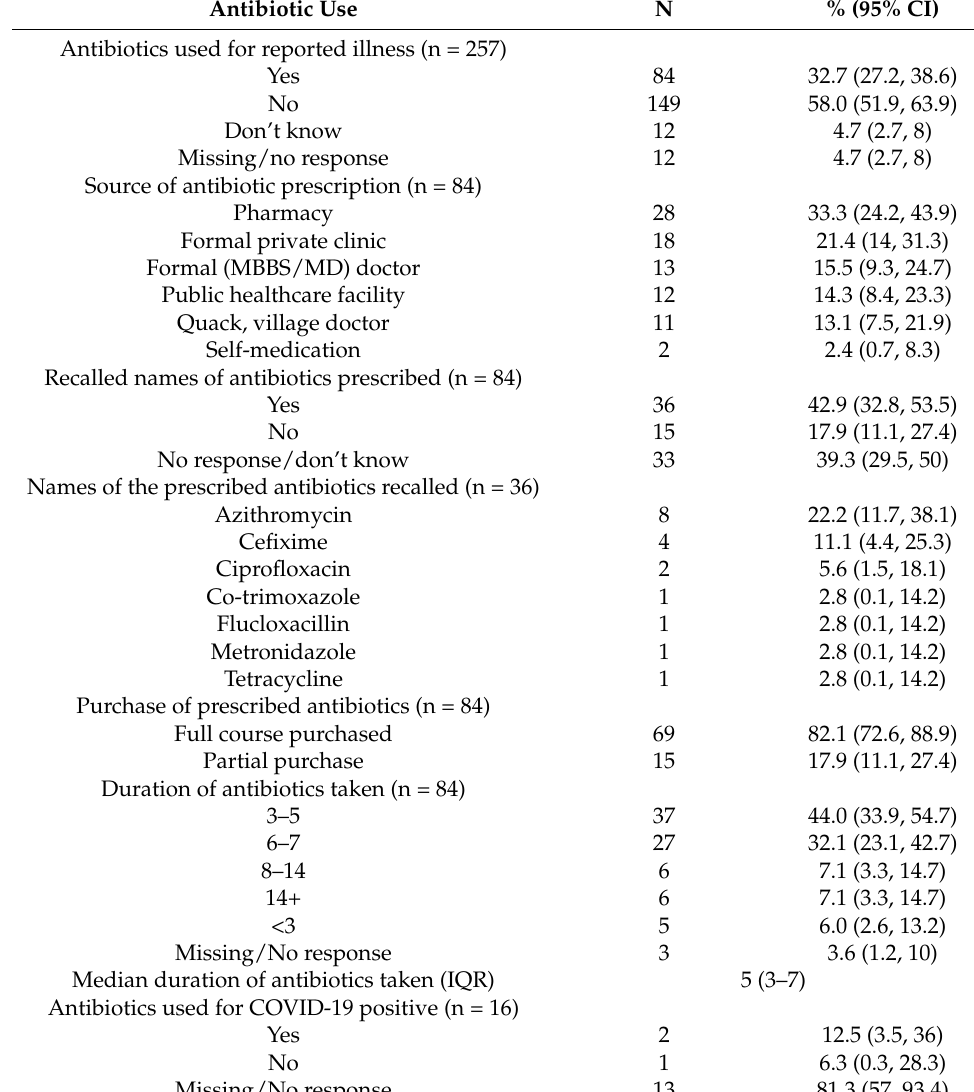
Table 2. Use of antibiotics among the general population who reported illness in the preceding four weeks of the interview during the COVID-19 pandemic in